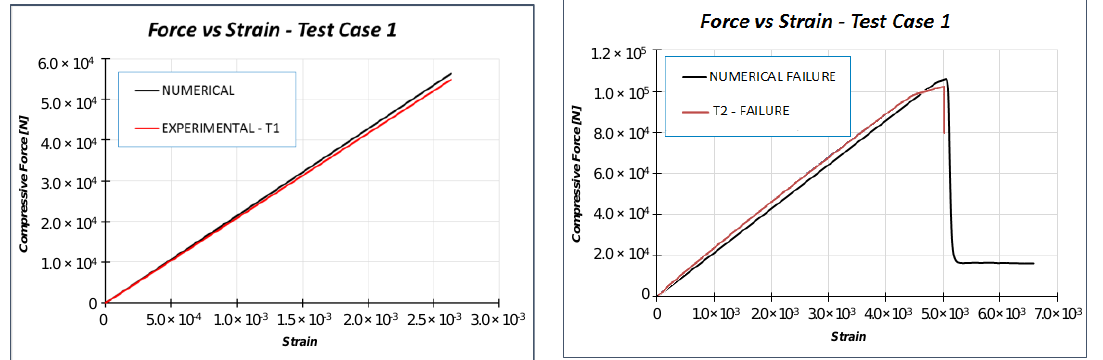
Table 3. Numerical-experimental comparisons: Stiffness and failure load.